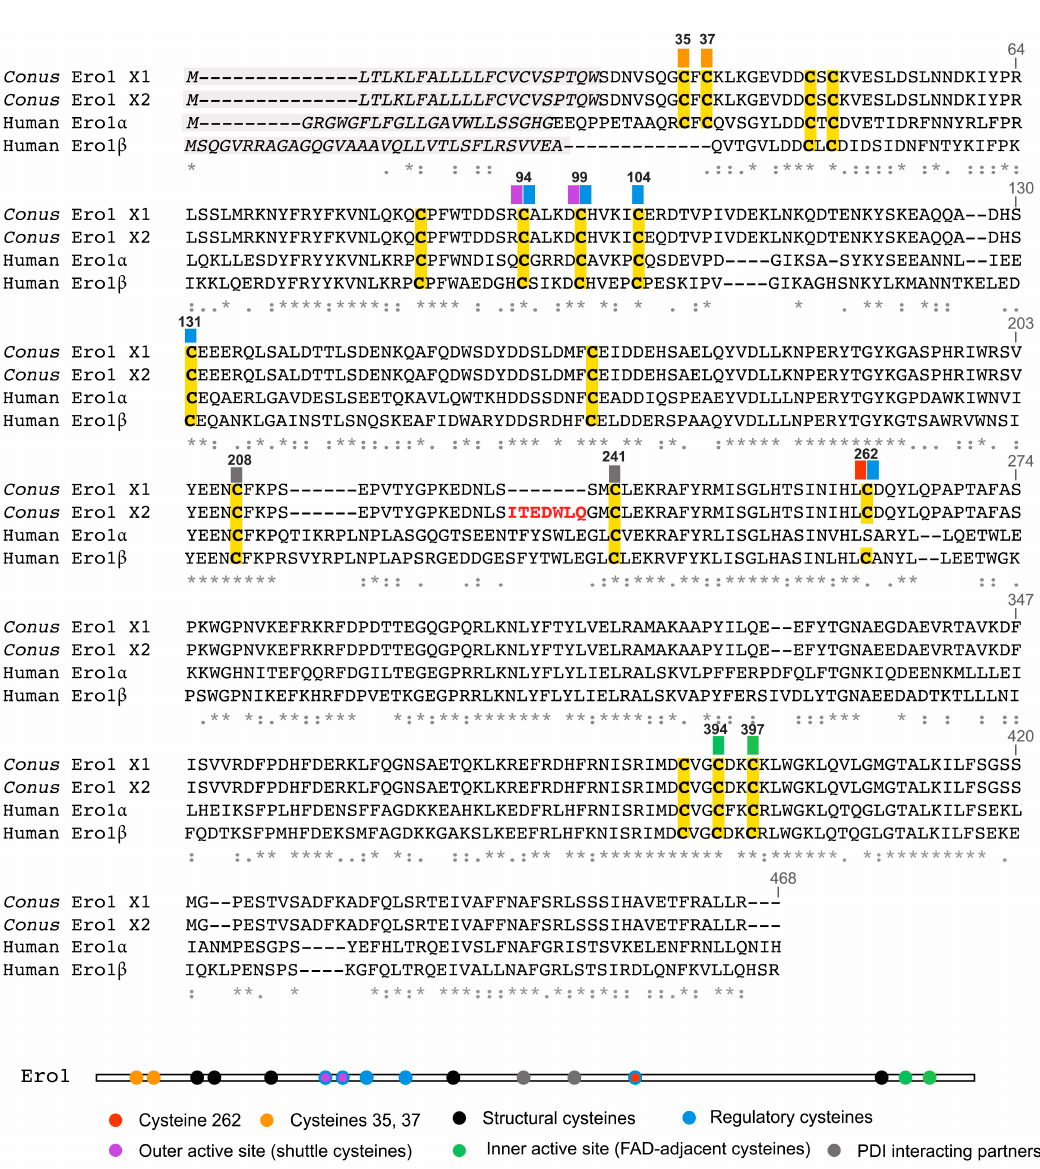
Figure 1. Comparative sequence alignment of the two endoplasmic reticulum oxidoreductin-1 (Ero1) isoforms identified in Conus geographus ( Conus Ero1 X1 and X2) with human Ero1 α and Ero1 β . Predicted signal sequences are shown in gray, cysteines are highlighted in yellow. Conus Ero1 X1 and Ero1 X2 differ by seven amino acids (shown in red). Boxes above cysteines are color-coded according to their proposed functions [11–14]. The same color scheme is used in the schematic below the alignment. Numbering of cysteines is based on the human Ero1 α sequence. Sequence alignment was generated using Multiple Alignment using Fast Fourier Transform (MAFFT)x [15]. Amino acid conservations are denoted by an asterisk ( * ). Full stops ( . ) and colons ( : ) represent a low and high degree of similarity, respectively. FAD = flavin adenine dinucleotide; PDI = protein disulfide isomerase.